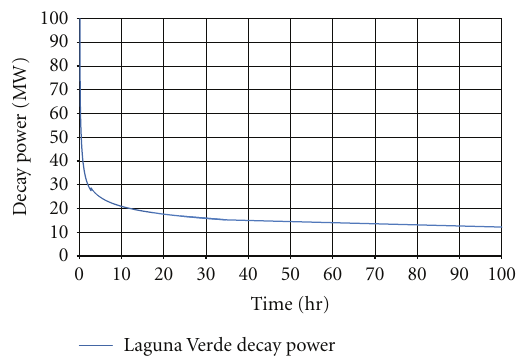
Figure 25: Variation in decay heat after reactor scram.